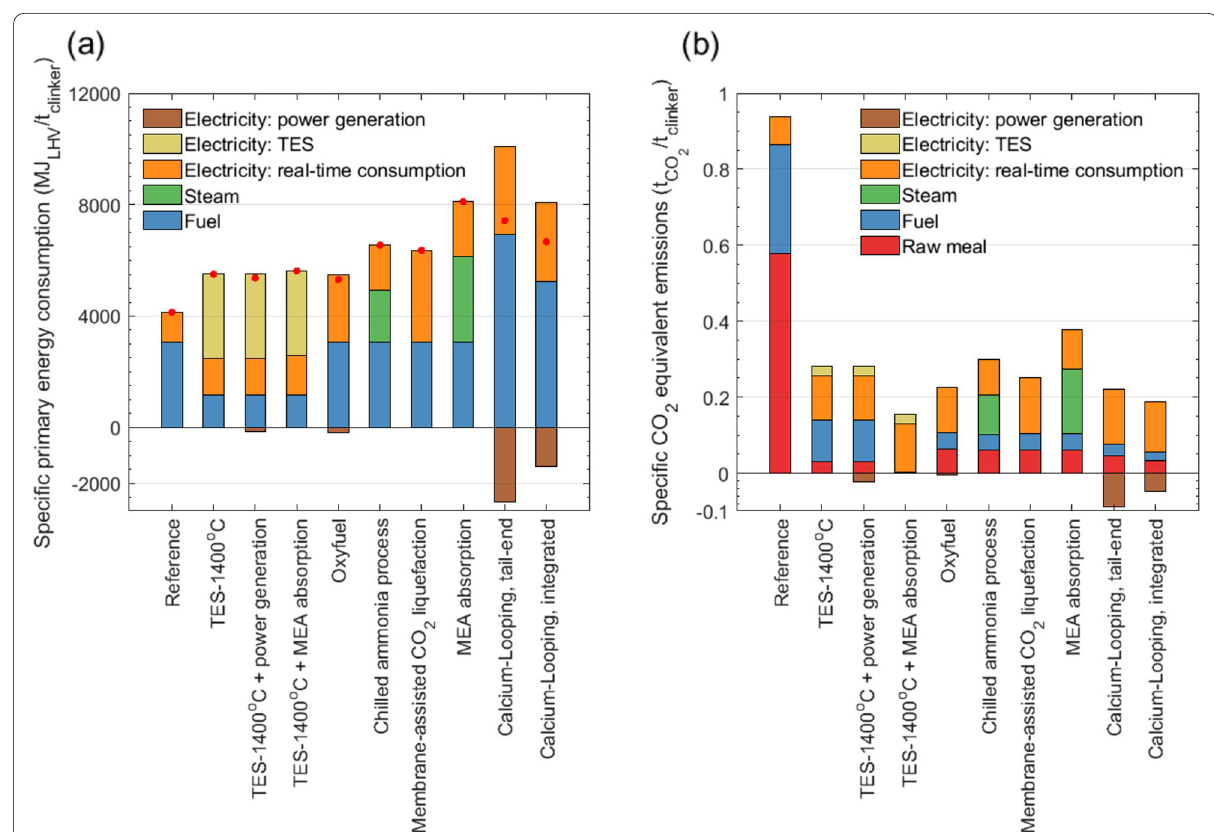
Fig. 6 a The specific primary energy consumption and b CO 2 emissions of cement manufacturing with different carbon capture technologies [22]. The reference data refers to the case without CO 2